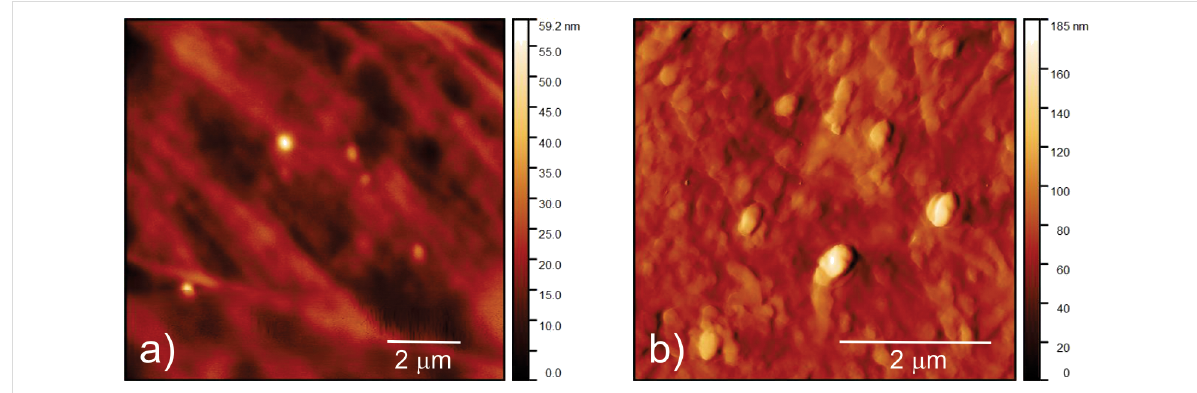
Figure 1: (a) Top-view AFM image of neat PU and (b) top-view AFM image of a CQDs/PU composite.